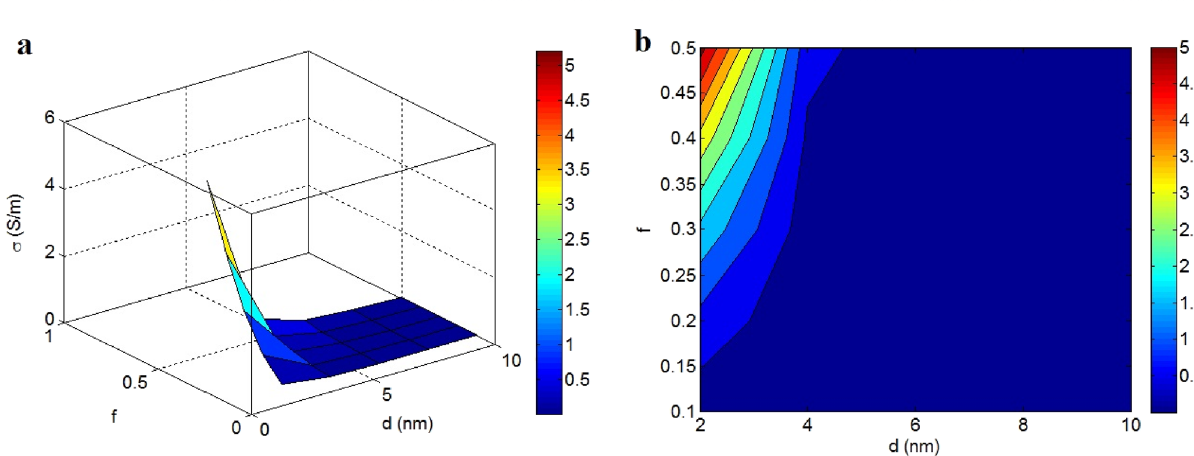
Figure 5. Impacts of “ φ f ” and “t i ” on the conductivity in t = 2 nm, D = 2 μm, σ f = 10 5 S/m, d = 5 nm and K = 2 by ( a ) 3D and ( b ) contour schemes.